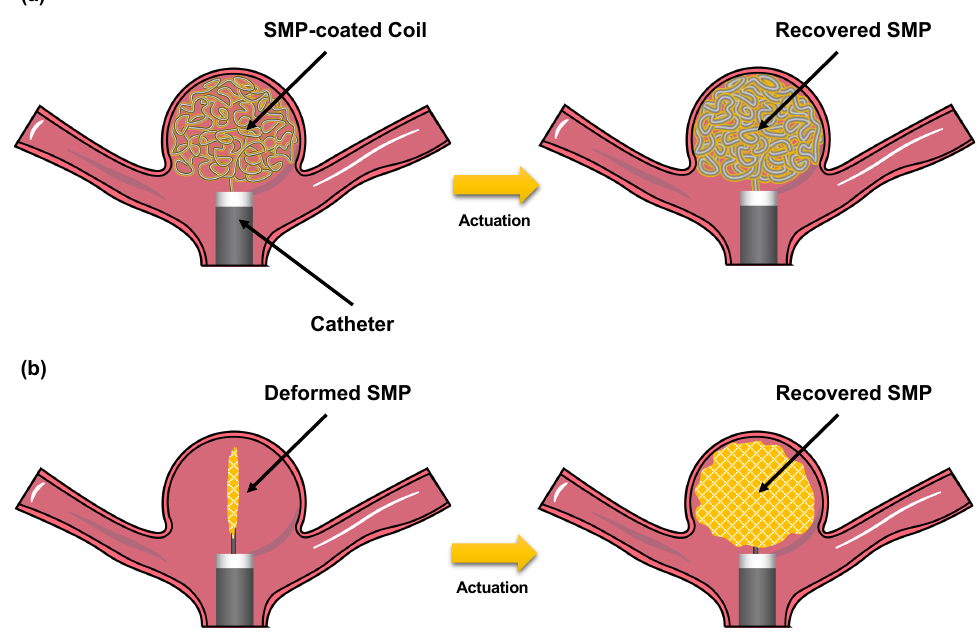
Figure 2. Schematic of two potential approaches to fabricate shape memory polymer (SMP)-based endovascular devices for ICA treatment: ( a ) SMP-coated coils; and ( b ) SMP coil-free foams with patient-specific